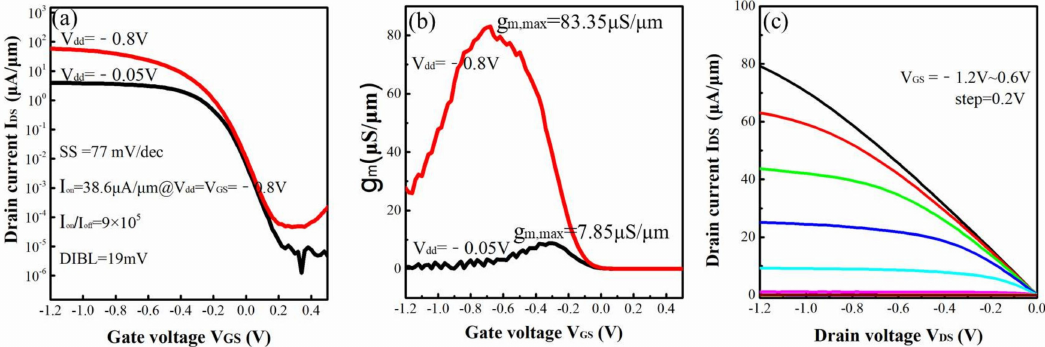
Figure 7. ( a ) I DS -V GS , ( b ) g m -V GS and ( c ) I DS -V DS characteristics of the four-levels vertically stacked Si 0.7 Ge 0.3 NWs GAA